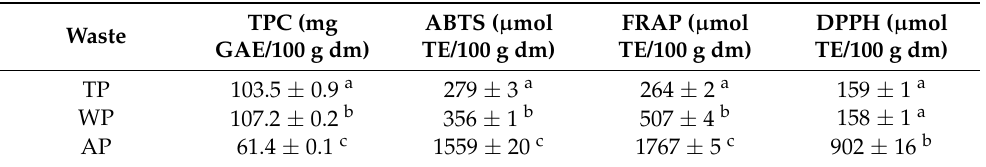
Table 2. Total phenolic content and antioxidant activity of different extracts obtained from tomato, watermelon and apple wastes by UAE ( n = 3, mean ± SD). Different superscripts in the same column indicate significantly different values ( p < 0.05). dm: dry